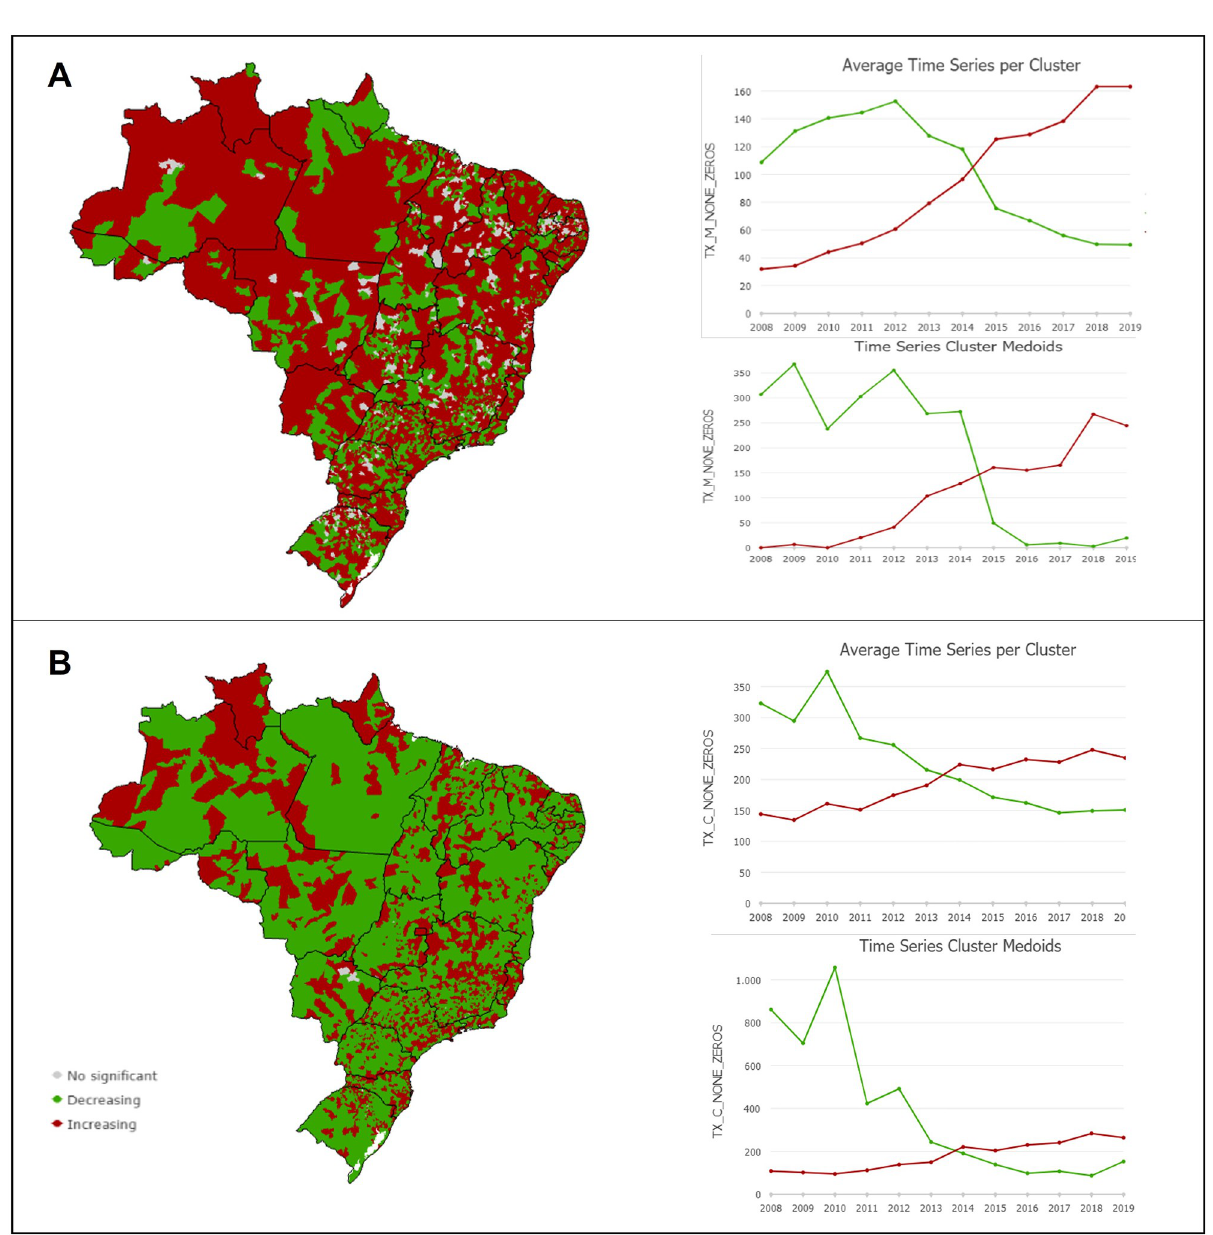
Fig 5. Time-series clustering of PCSC over the first thousand days. (A) Spatiotemporal clusters of PCSC rates in women due to causes related to prenatal care and childbirth. (B) Spatiotemporal clusters of PCSC rates in children under two years old.